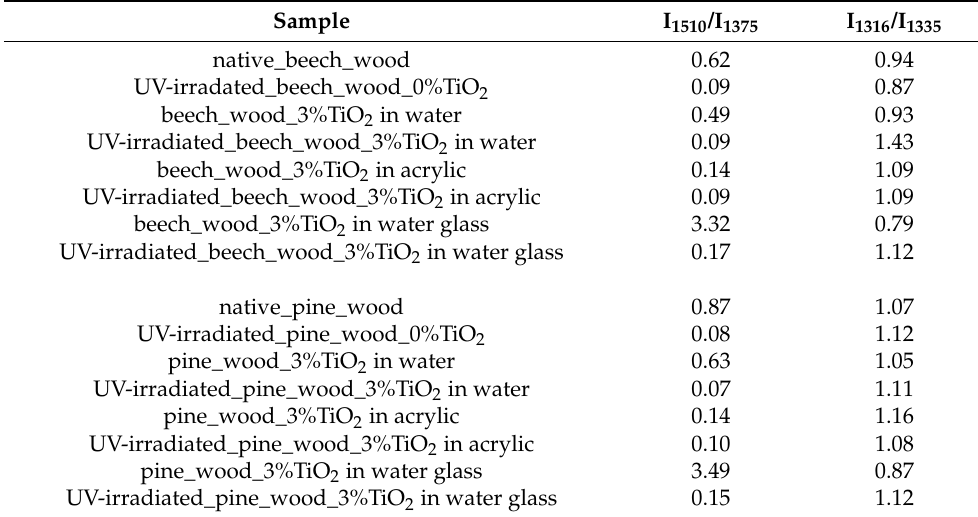
Table 3. Photodegradation parameters: rate of delignification (ratio of band at 1510 to 1375 cm − 1 ), crystallinity of cellulose (ratio of band at 1316 to 1335 cm − 1 ).